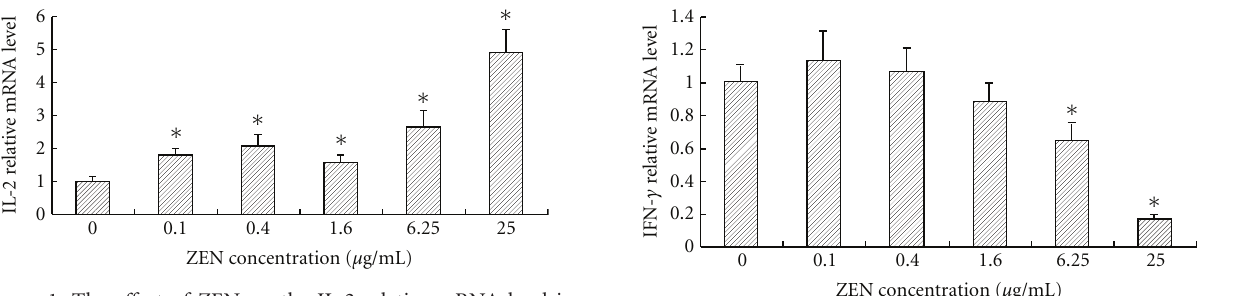
Figure 1: The e ff ect of ZEN on the IL-2 relative mRNA level in ConA-stimulated lymphocytes at toxin concentration of 0, 0.1, 0.4, 1.6, 6.25, and 25 μ g/mL at 48h. The reporter activity in response to ConA alone is expressed as 100%. Values are the means ± SD from three independent experiments. Statistical analysis was performed using one-way ANOVA followed by Dunnett’s post hoc test ( ∗ P < 0 . 05 versus ConA treated control).